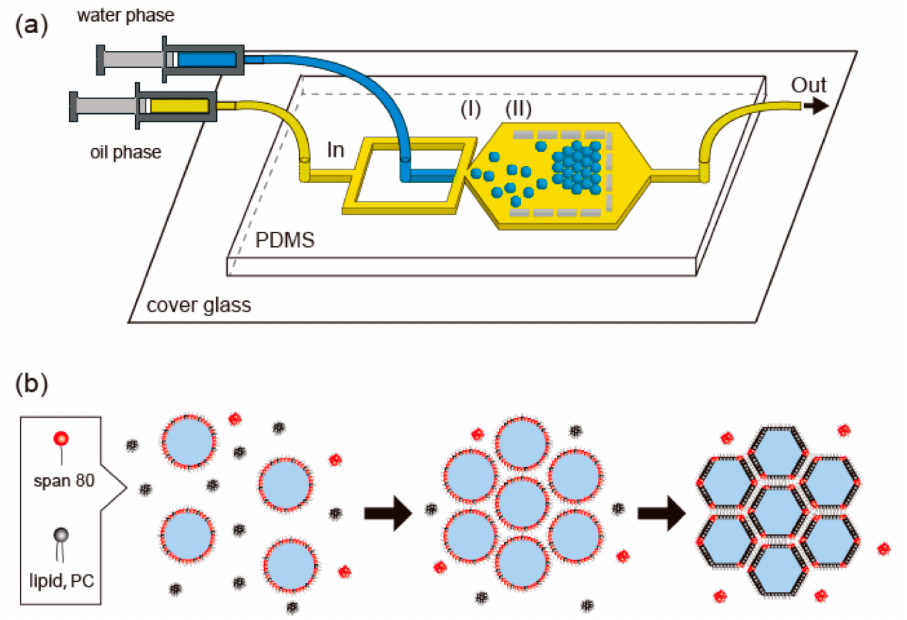
Figure 27. Schematic representation of ( a ) a microfluidic device for preparing the close-packed honeycomb pattern of assembled droplets in a two-dimensional space [( I )—droplets are gener- ated via flow-focusing; ( II )—droplets are trapped and assembled in a U-shaped chamber] and of ( b ) droplet interface bilayer (DIB) formation among droplets. Span 80 molecules (red), having a higher adsorption rate than lipid 1,2-dioleoyl-sn-glycero-3-phosphocholine (PC, black), initially accu- mulate on the droplet surface. Replacement of Span 80 with PC initiates DIB formation and surface adhesion among droplets. Reprinted from an open-access source